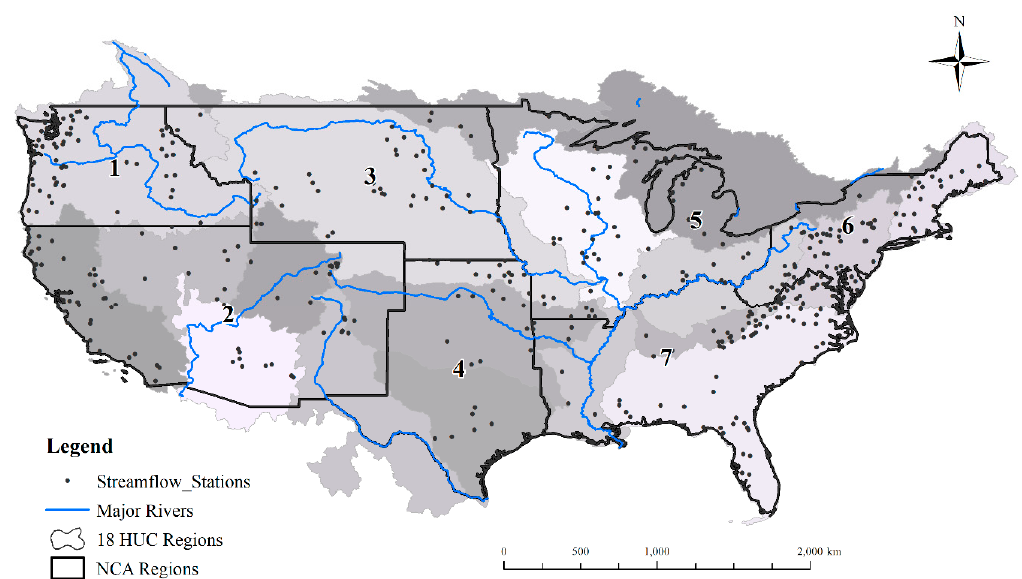
Figure 1. Map showing the locations of 419 unimpaired streamflow within National Climate Assessment regions (1 — Northwest, 2 — Southwest, 3 — Northern Great Plains, 4 — Southern Great Plains, 5 — Midwest, 6 — Northeast, and 7 — Southeast). The map also shows 18 United States Geological Survey Hydrologic Unit catchments along with major rivers.